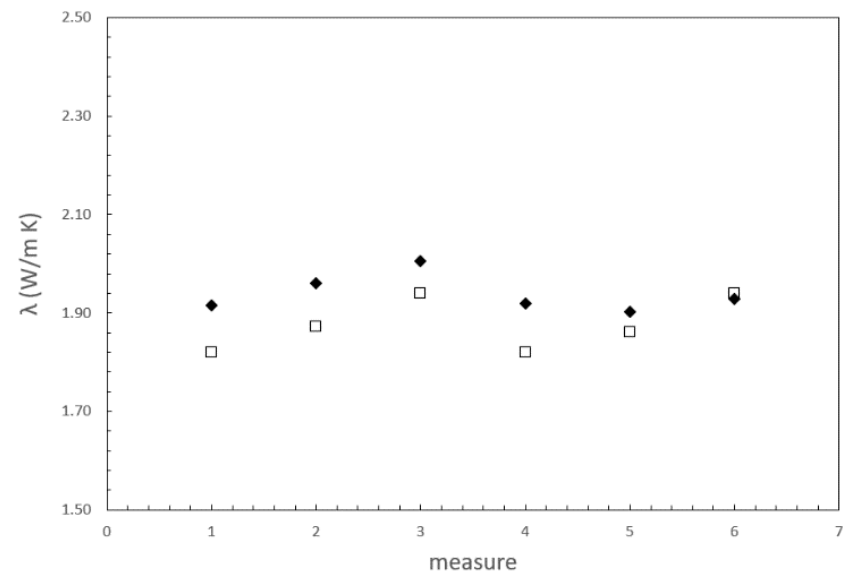
Figure 4. Diagram of the repeated measurements of thermal conductivity obtained on the standard and doped (ST with 5% of CFP) bentonitic grouts. Symbols are as follows: squares for the standard grout; diamond for the grout plus 5% of CFP.